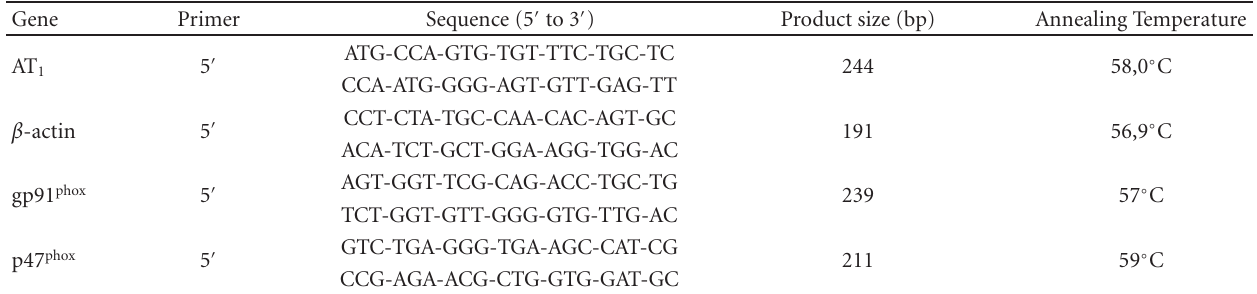
Table 1: PCR primer sequences for Real Time quantitative